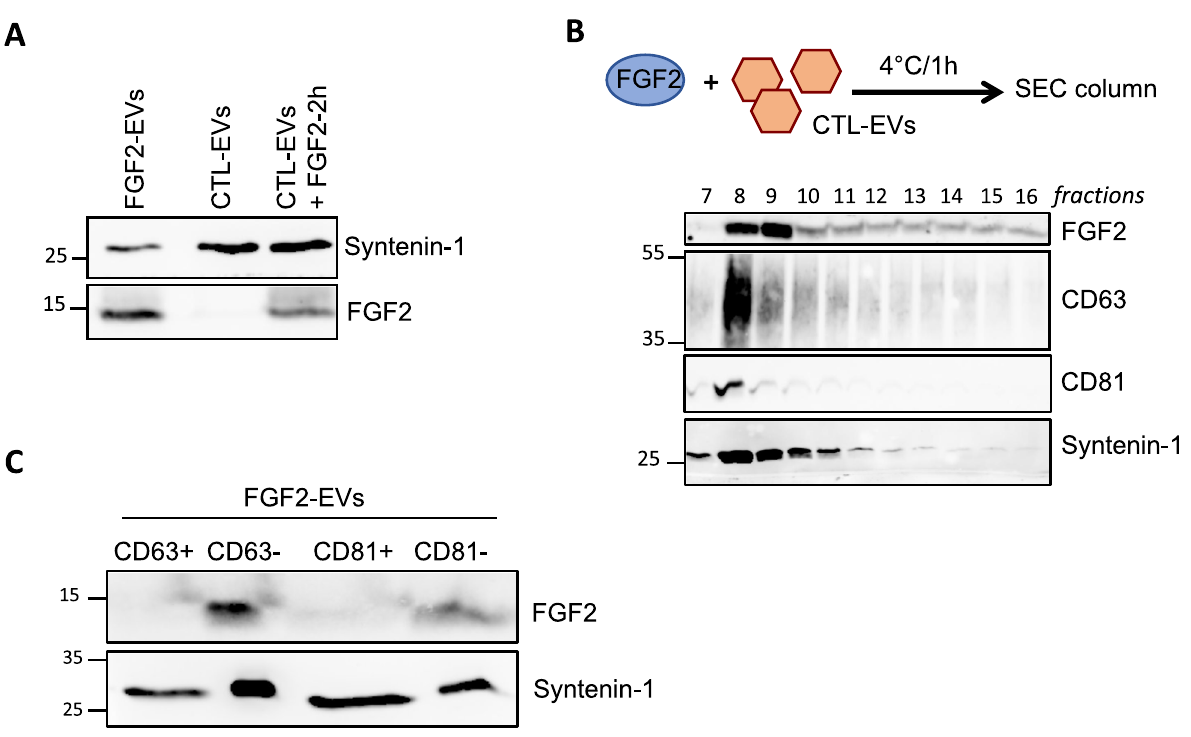
Figure 2. A CD63/CD81-negative subpopulation of EVs binds FGF2. ( A ) Cell-independent binding of FGF2 to DF-EVs. Conditioned medium from amplified CTL cells was transferred into new dishes. FGF2 (100 ng/ml) was added for 2 h at 37 °C and the medium was further processed for EV isolation. FGF2 expression in EVs (15 μg) was determined by western blot and compared to CTL- and FGF2-EVs. ( B ) Binding of FGF2 to purified CTL- EVs. FGF2 (100 ng/ml) was incubated with purified CTL-EVs (1E + 10p) for 1 h on ice before insertion into the SEC column. One hundred microliters from 200 μl of each collected fraction were analyzed by western blot with FGF2, CD63 and syntenin-1 antibodies. ( C ) Immuno-isolation of FGF2-EVs (1E + 10p) with beads coupled with anti-CD63 or anti-CD81 antibody. Positive (total amount) and negative (1:5 (v/v) of the flow-through) fractions were analyzed by western blot for FGF2 and syntenin-1 expression. Representative blots are shown. Original blots are shown in Suppl. Information. Validation of the immunoprecipitation is shown in Suppl. Fig.